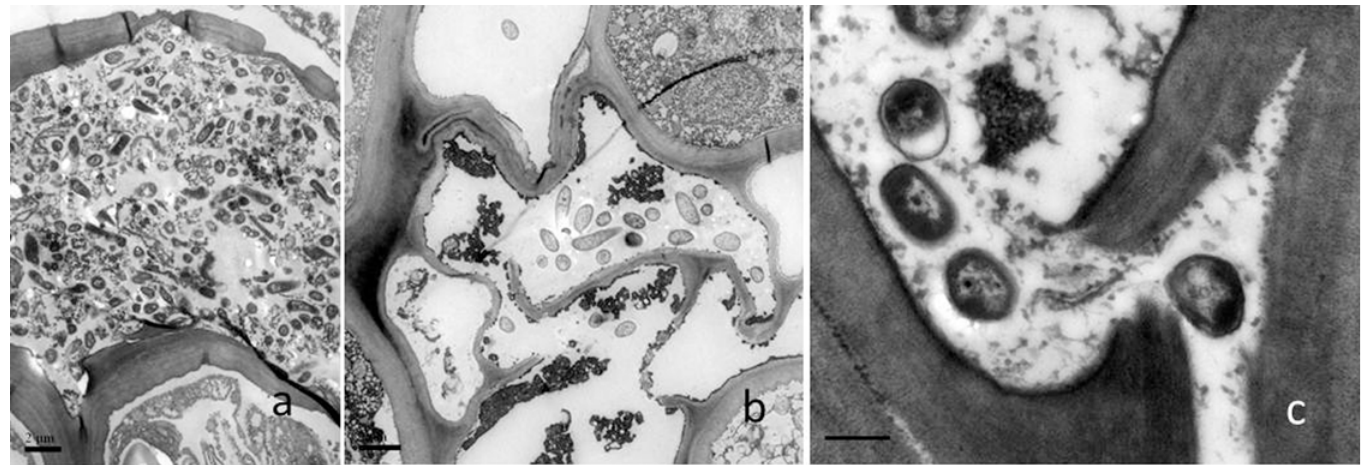
Fig 5. Transmission electron micrographs of cross sections of kiwifruit twigs infected with the GFPuv-labeled Psa 5 DAI. (a), Bacterial cells in intercellular spaces of the parenchyma. Bar = 2 μ m; (b), bacterial colonization in parenchyma cells where the cell walls are ruptured and organelles have disintegrated. Bar = 2 μ m; (c), bacterial colonization in intercellular spaces where the middle lamella tended to be ruptured. Bar = 0.5 μ m.